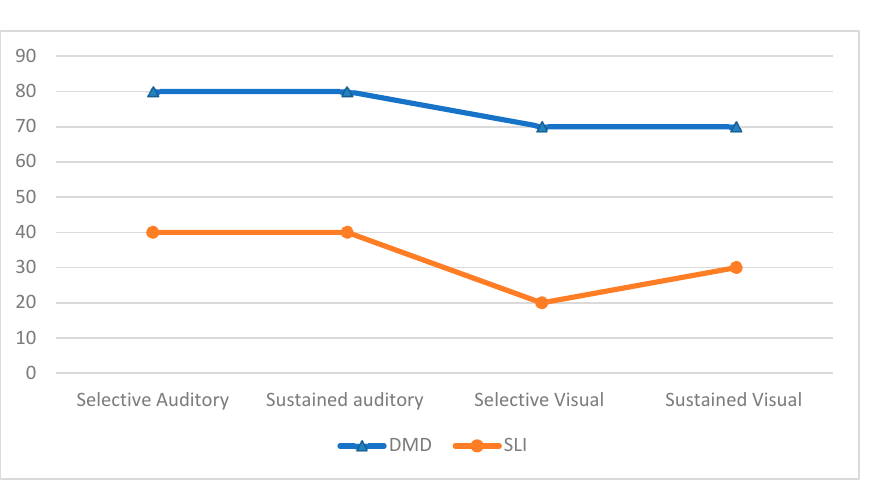
Figure 2. Percentage distribution of abnormal results on the attention tests in the DMD and SLI groups.